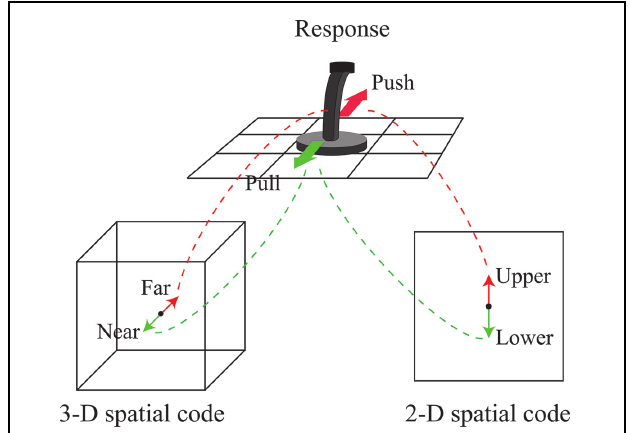
FIGURE 1 | Illustration of the relationship among two-dimensional (2-D) and three-dimensional (3-D) response codes and the action with the response